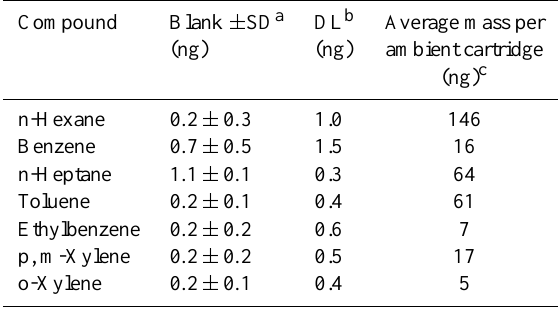
Table 1. Averages of background signals for cartridges containing (1 ± 0 . 2)g of Carboxen and 0.2 to 0.5g of quartz